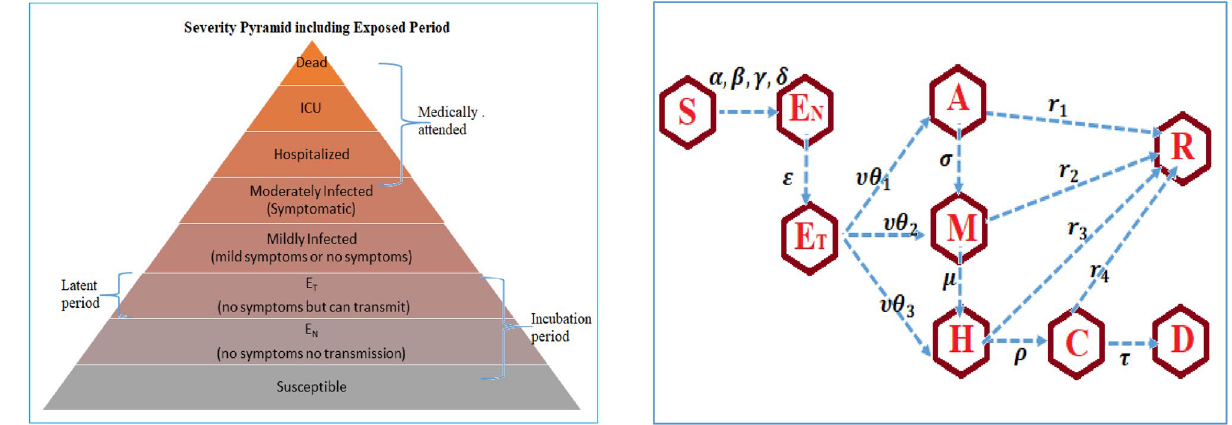
Figure 3. Extension of the model by including exposed